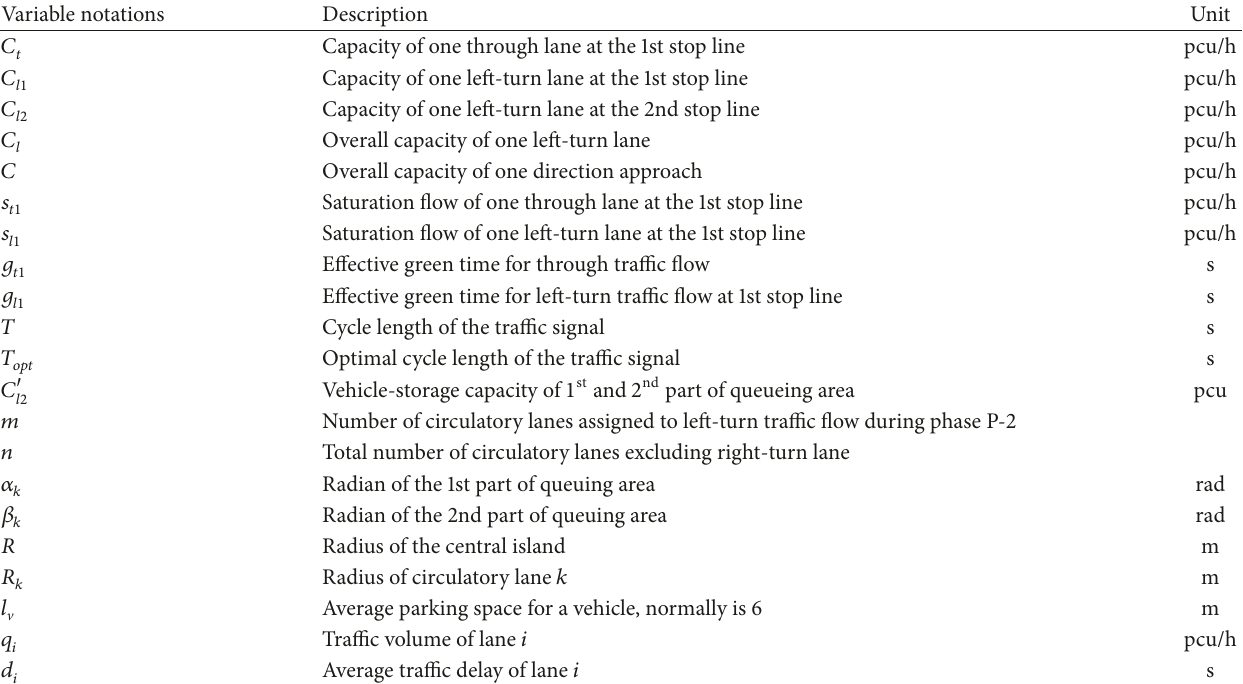
Table 1: Variable notations in this